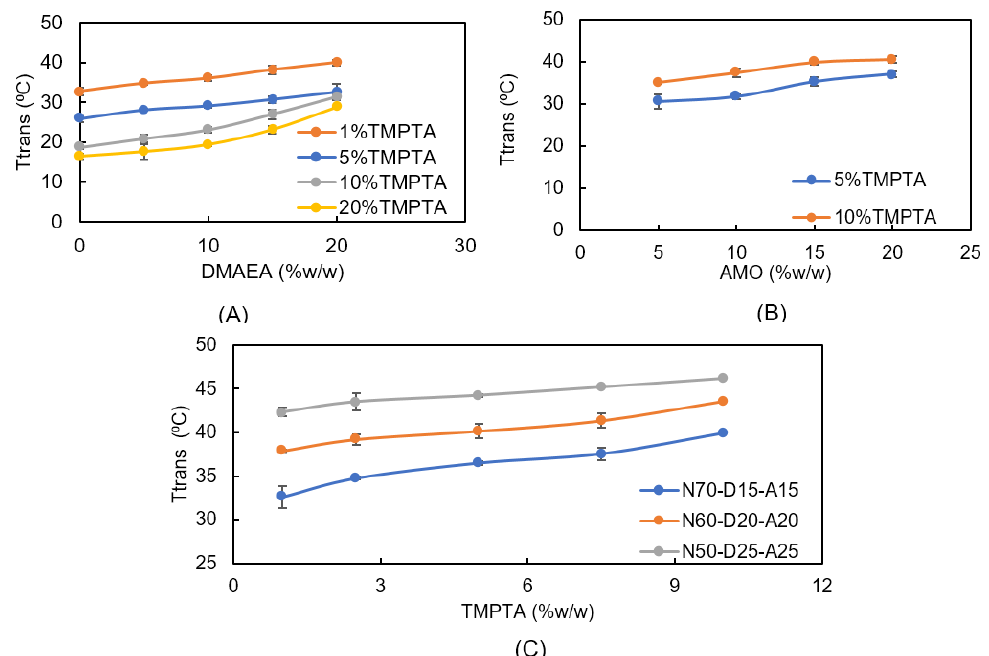
Figure 1. Transition temperatures of photo-polymerized discs as obtained by DSC. ( A ) Resins with 1–20% w / w TMPTA, 0–20% w / w DMAEA, and 0% w / w AMO. ( B ) Effect of AMO on transition temperature (5–10% w / w TMPTA, 15% w / w DMAEA). ( C ) Effect of TMPTA (1–10% w / w ) on transition temperature in different resin formulations (N70-D15-A15, N60-D20-A20, and N50-D25-A25).